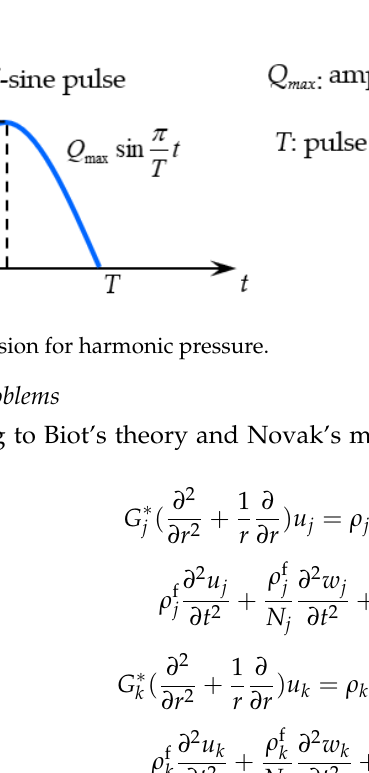
Figure 1. Coupled vibration of a pile–soil system.